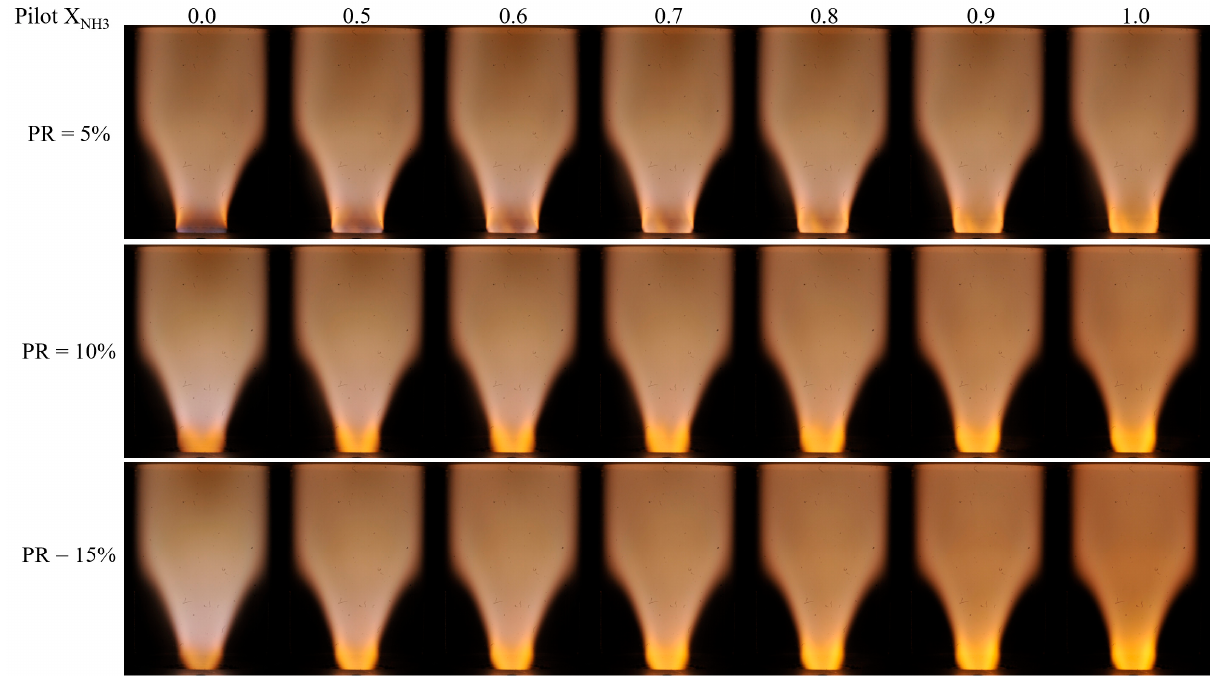
Figure 8. Time-averaged broadband images of NH 3 –CH 4 –air flames as a function of the pilot NH 3 fraction for PR = 5 ( top row ), 10 ( middle row ), and 15% ( bottom row ).